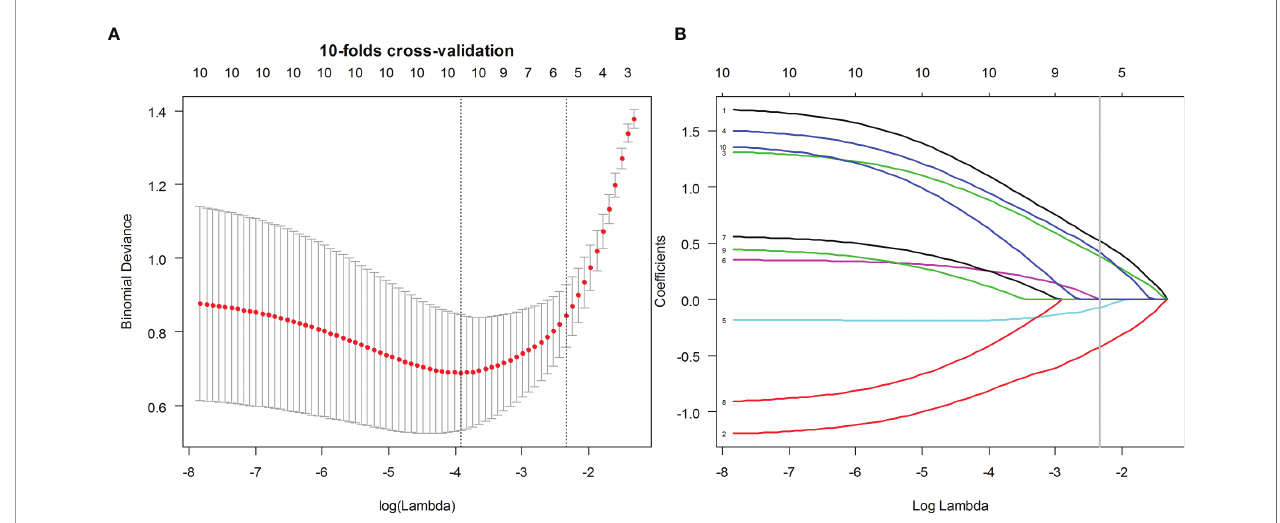
FIGURE 2 | Ultrasound image feature selection using the least absolute shrinkage and selection operator (LASSO) logistic regression model in the training dataset. (A) The 10-fold cross-validation and the minimal criteria process were used to generate the optimal penalization coef fi cient lambda in the LASSO model. (B) LASSO coef fi cient pro fi les of the BMUS and ES features. The dotted vertical line was drawn at the value selected by 10-fold cross-validation when the optimal l resulted in eight (BMUS) and fi ve (ES) nonzero coef fi cients,